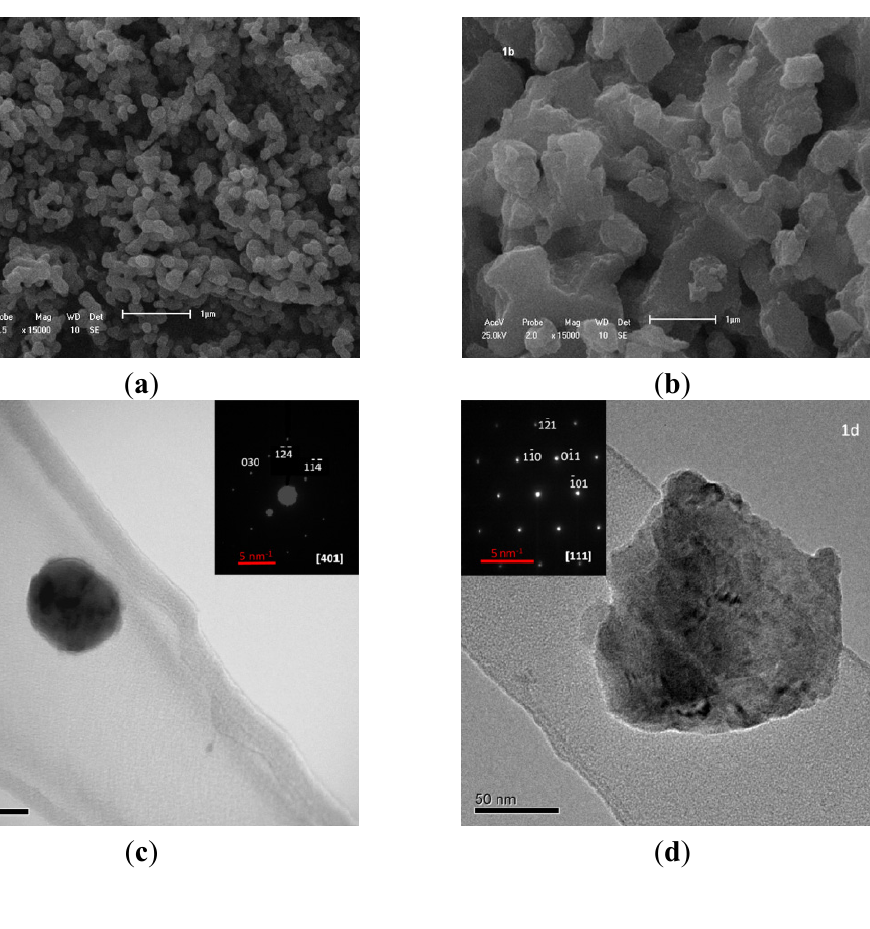
Figure 1. Electron microscopy images of ( a , c ) for LNCO and ( b , d ) for SFCO, ( c ) and ( d ) correspond to TEM images of elementary grain of the powders. The inserted pictures, in ( c ) and ( d ), correspond to the electron diffraction patterns confirming